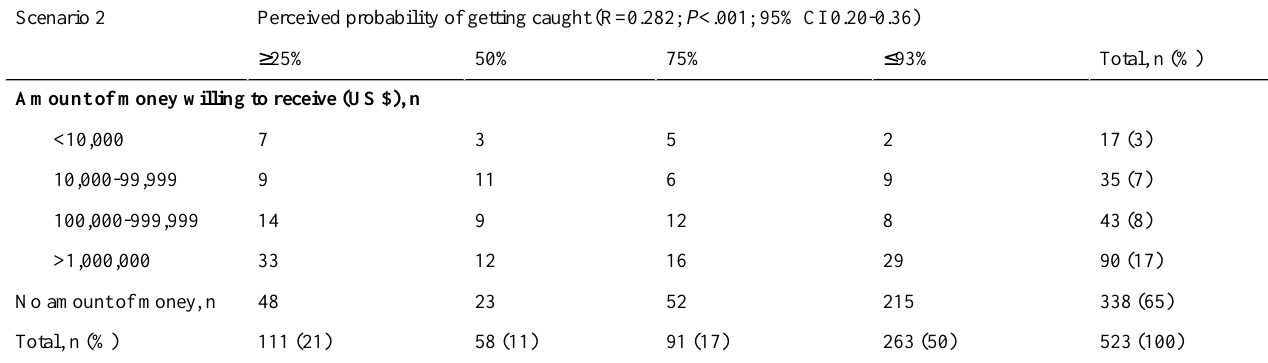
Table 2. Doctor, no personal context (scenario 2).